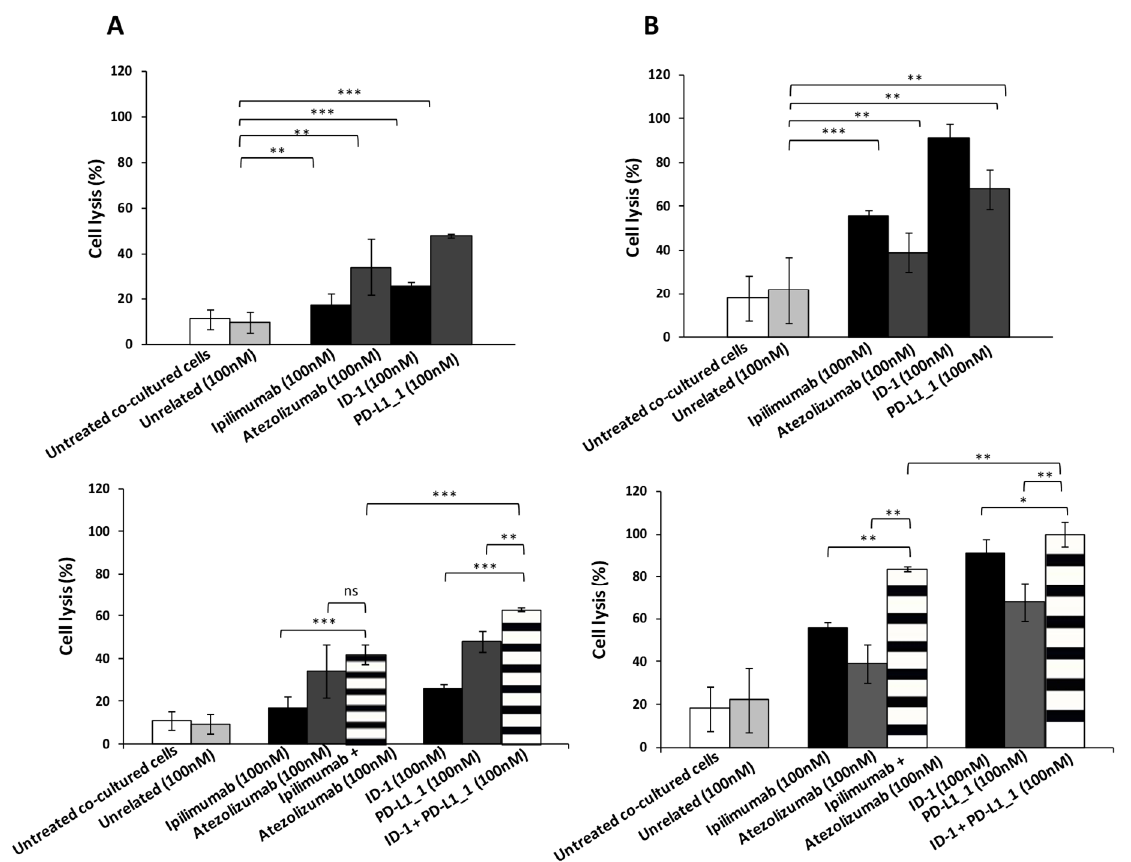
Figure 2. Cytotoxic effects of novel immunomodulatory mAbs on tumor cells co-cultured with hPBMCs. BT-549 ( A ) or MDA-MB-231 ( B ) tumor cells were co-cultured with hPBMCs (Effector:Target cells ratio 5:1) and treated for 48 h with anti-CTLA-4 (black bars) and anti-PD-L1 (dark grey bars) mAbs or their combination (striped bars) at the indicated concentrations. Co-cultured cells untreated or treated with an unrelated IgG were used as negative controls (white and grey bars, respectively). Cell lysis was measured by detecting LDH release, as described in Materials and Methods. Error bars depict means ± SD. p -values for the indicated compounds are: *** p ≤ 0,001; ** p < 0.01; * p < 0.05.